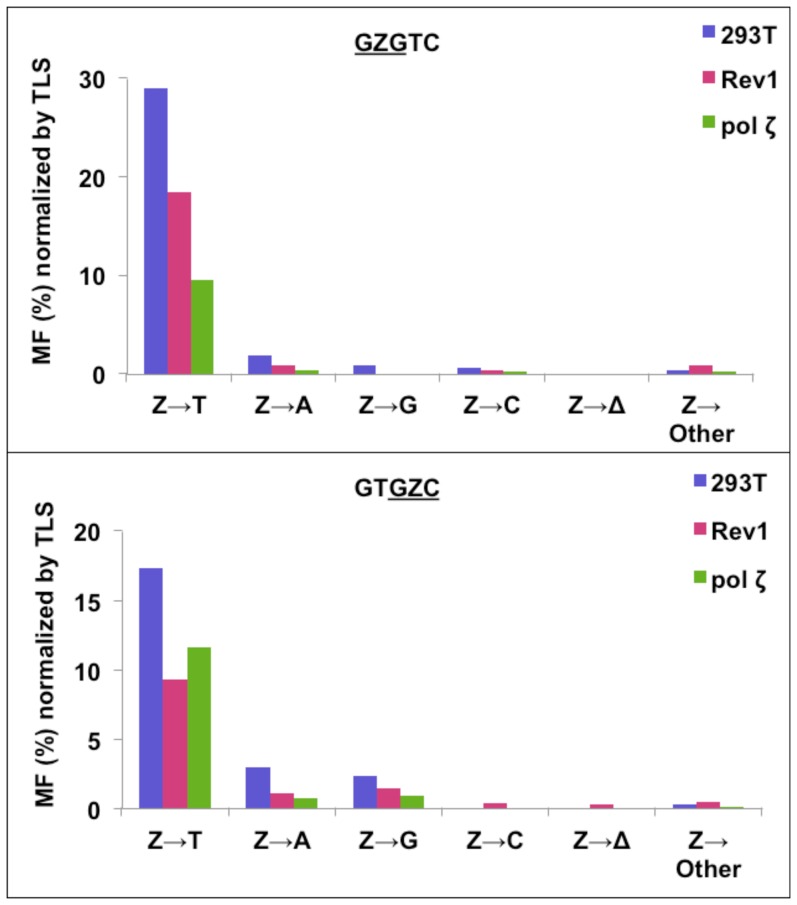
Percent mutations induced by Z in
GZGTC and GTGZC
 sequence contexts normalized by TLS (i.e., % MF multiplied with TLS frequency in hundredths) for
GZGTC and GTGZC
 constructs in HEK 293T cells without or with siRNA knockdowns of pol ζ and Rev1.